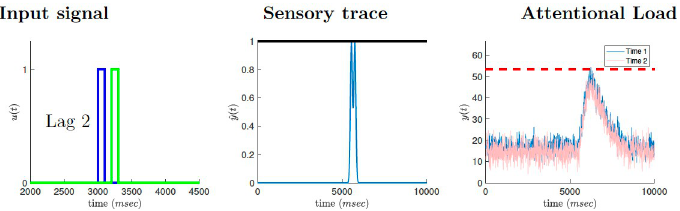
Fig 6. Mental training induced modulation of attentional load reduces blink probability. The attentional load profiles before and after meditation (right, blue and red traces respectively). The effects of meditation are modelled as a reduction in mental noise mean from 17.5 to 14.5 and an increase in mental noise standard deviation from 3.15 to 3.8.